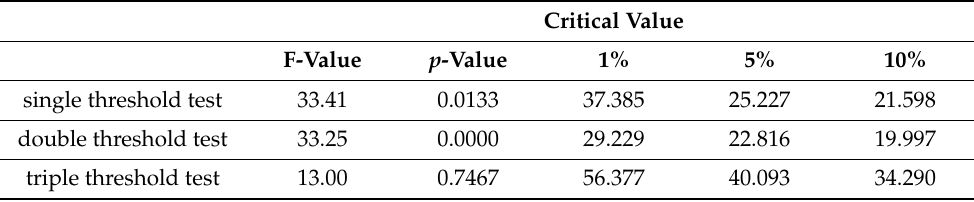
Table 4. Regression results of threshold effect test.